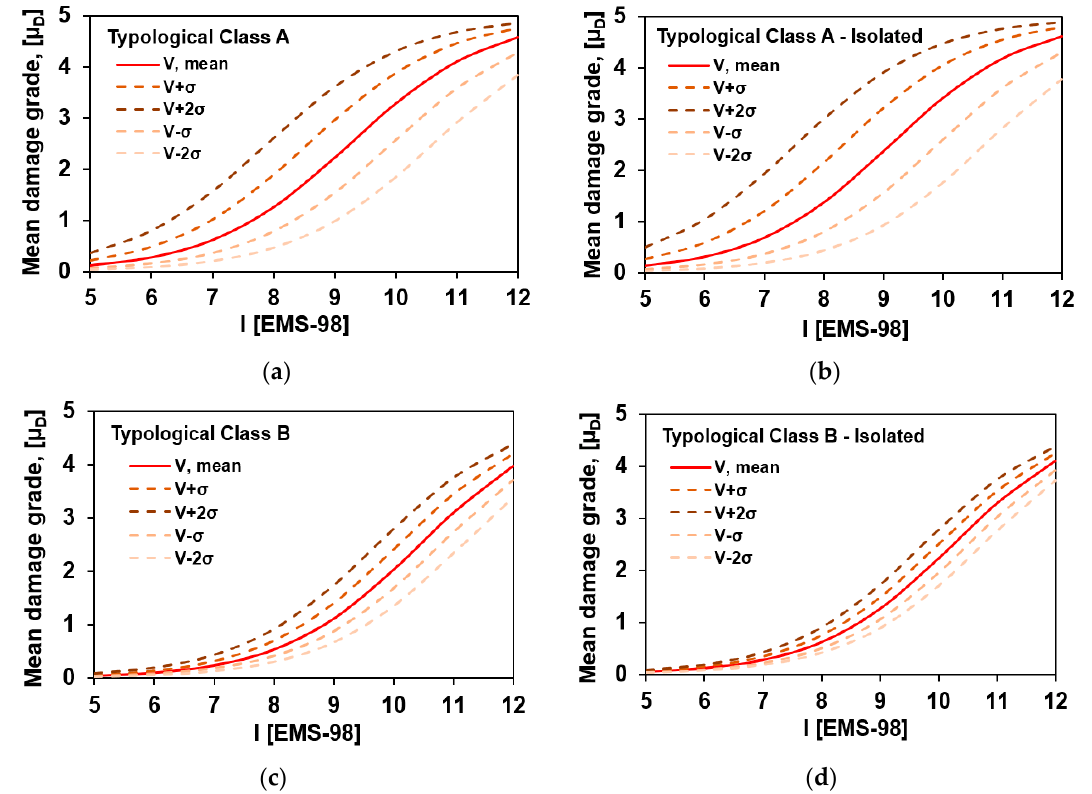
Figure 12. The mean typological vulnerability curves for examined building typologies.